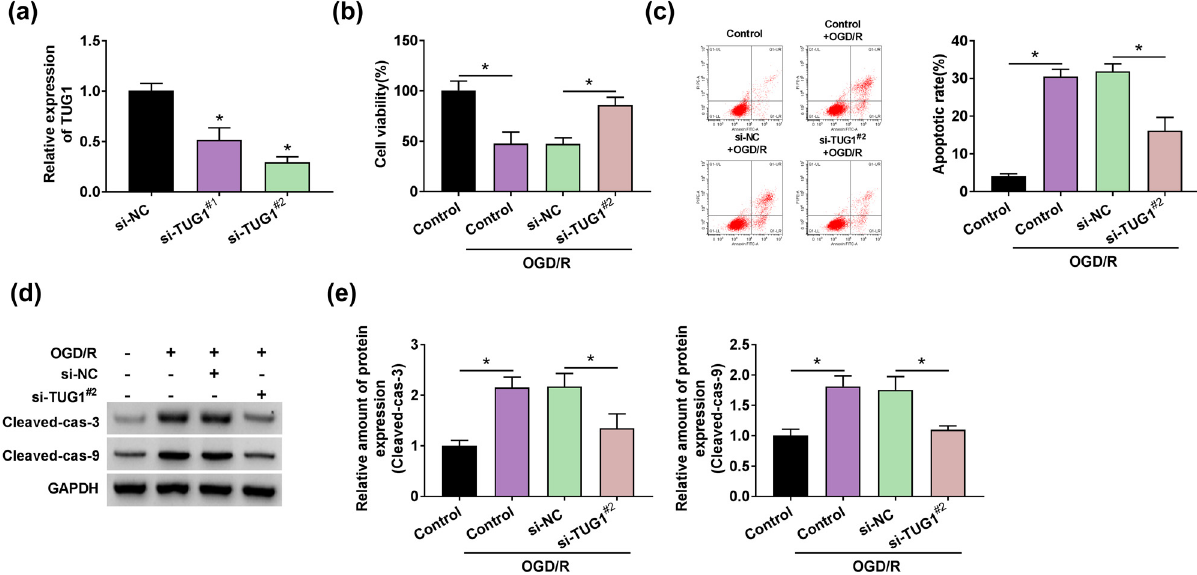
Figure 2: Knockdown of TUG1 hindered OGD/R - mediated decrease in viability and increase in apoptosis in N2a cells in vitro . ( a ) The transfection e ffi ciency of si - TUG1 ( si - TUG1 #1 , si - TUG1 #2 ) was assessed by RT - qPCR in N2a cells. ( b ) The e ff ect of si - TUG1 #2 on cell viability was evaluated by CCK - 8 assay in N2a cells treated by OGD/R. ( c ) Flow cytometry assay was applied to detect the apoptosis rate in N2a cells treated by OGD/R. ( d and e ) The proteins levels of apoptosis - related markers ( cleaved - cas - 3 and cleaved - cas - 9 ) were performed by western blot assay in N2a cells treated by OGD/R. * P <